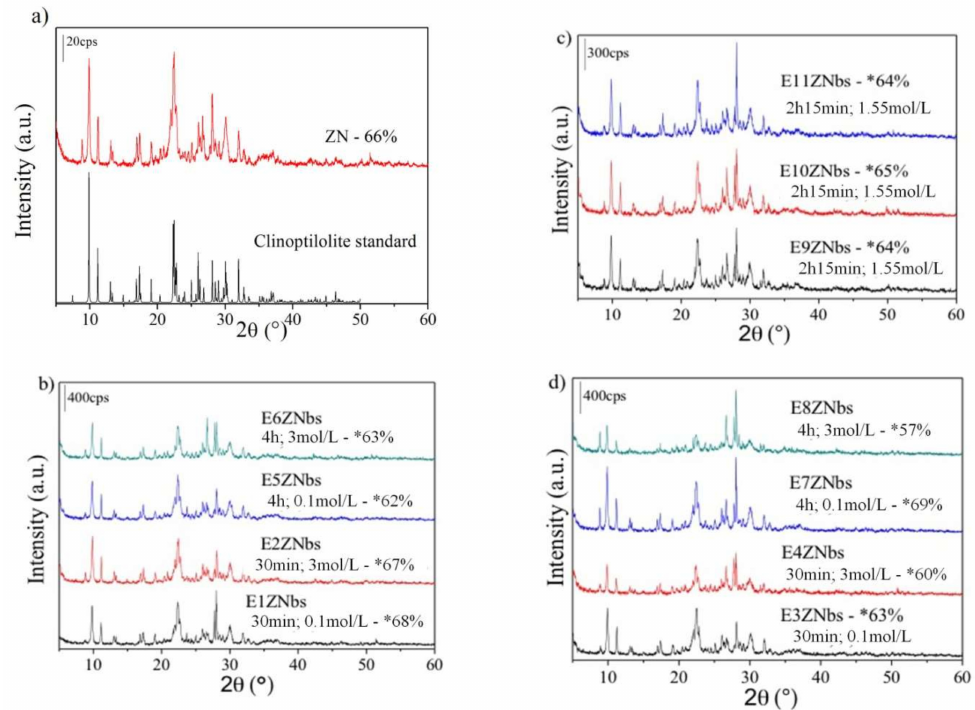
Figure 2. Diffractograms of natural zeolite and standard ( a ) and natural zeolites treated at: ( b ) 50 ◦ C, ( c ) 70 ◦ C, and ( d ) 90 ◦ C.